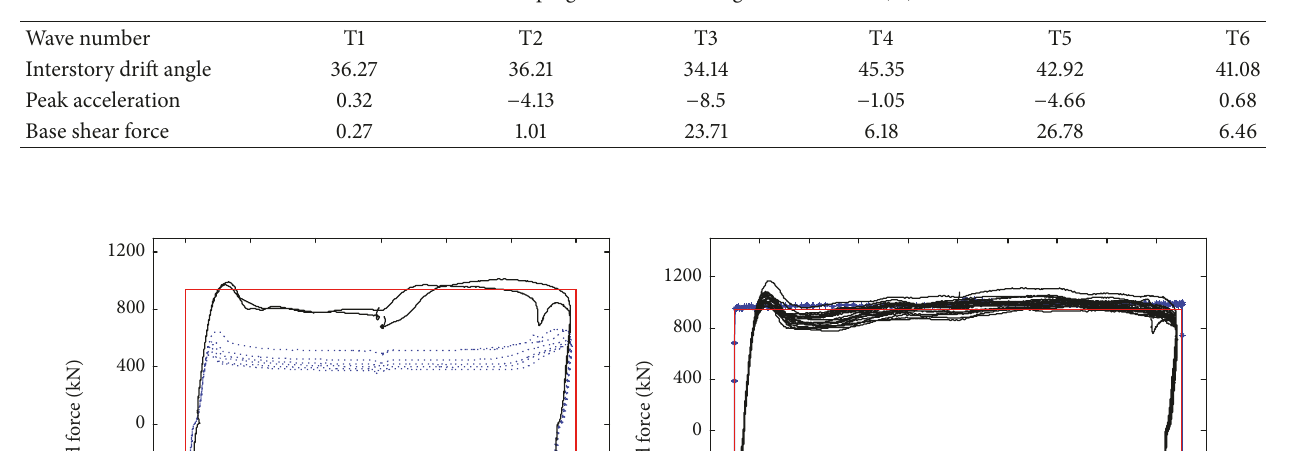
Table 2: Peak damping ratio of different ground motions (%).